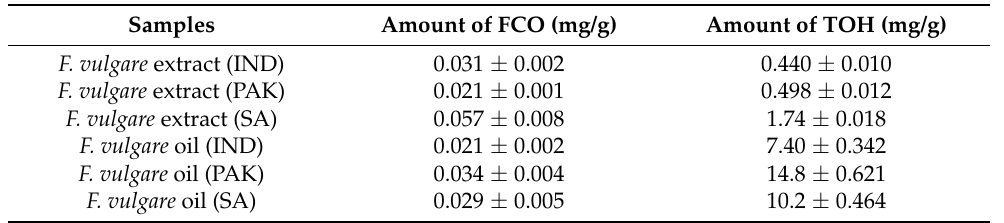
Table 4. Application of the proposed GC-MS approach in simultaneous determination of FCO and TOH in methanolic extracts and essential oils of F. vulgare obtained from different geographical regions (mean ± SD; n =